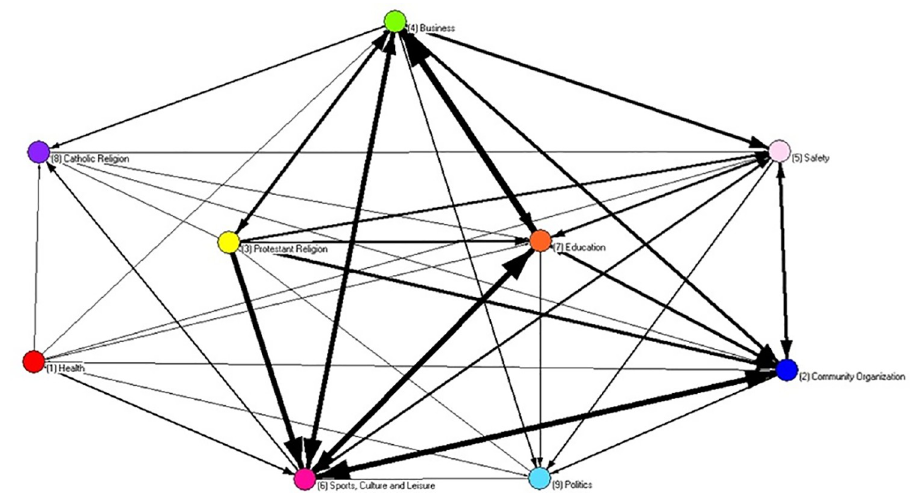
Fig 4. Digraph of beta community nodes have been collapsed by realms.